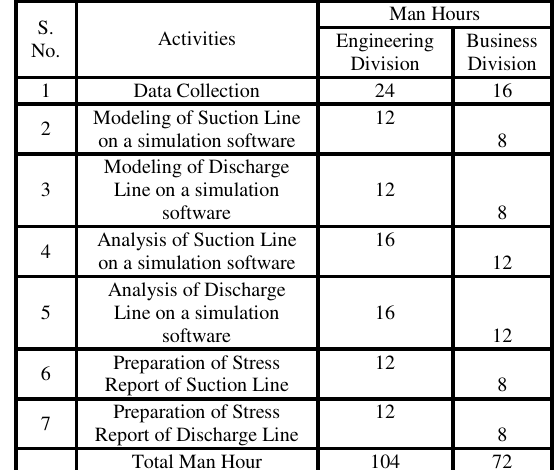
Table 1: Estimated Man-Hour Estimate of Critical